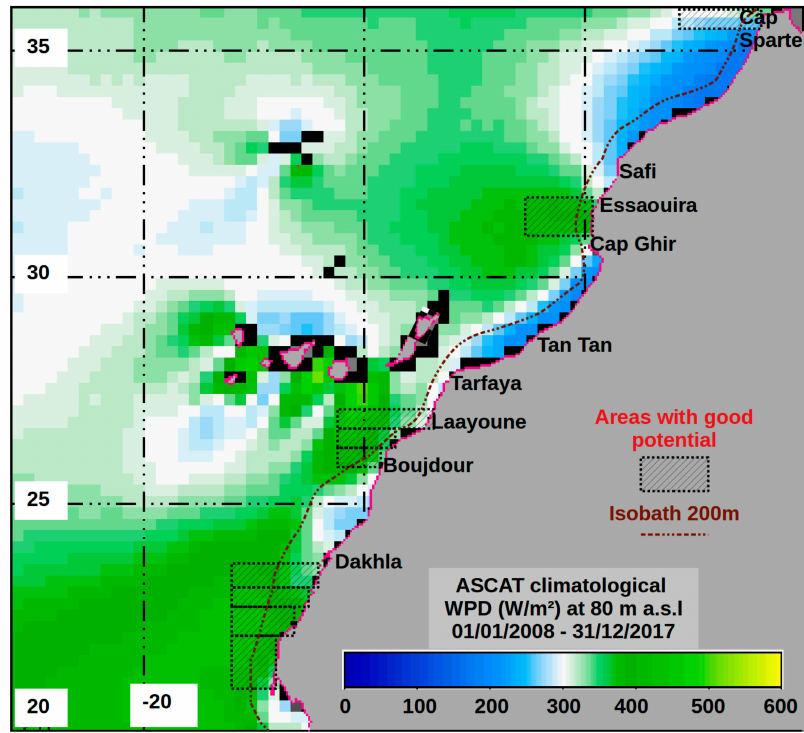
Figure 10. Annual average of WPD (W/m 2 ) computed from 3653 daily images for the period 2008–2017; the likely potential areas of future offshore farms are highlighted according to the WPD